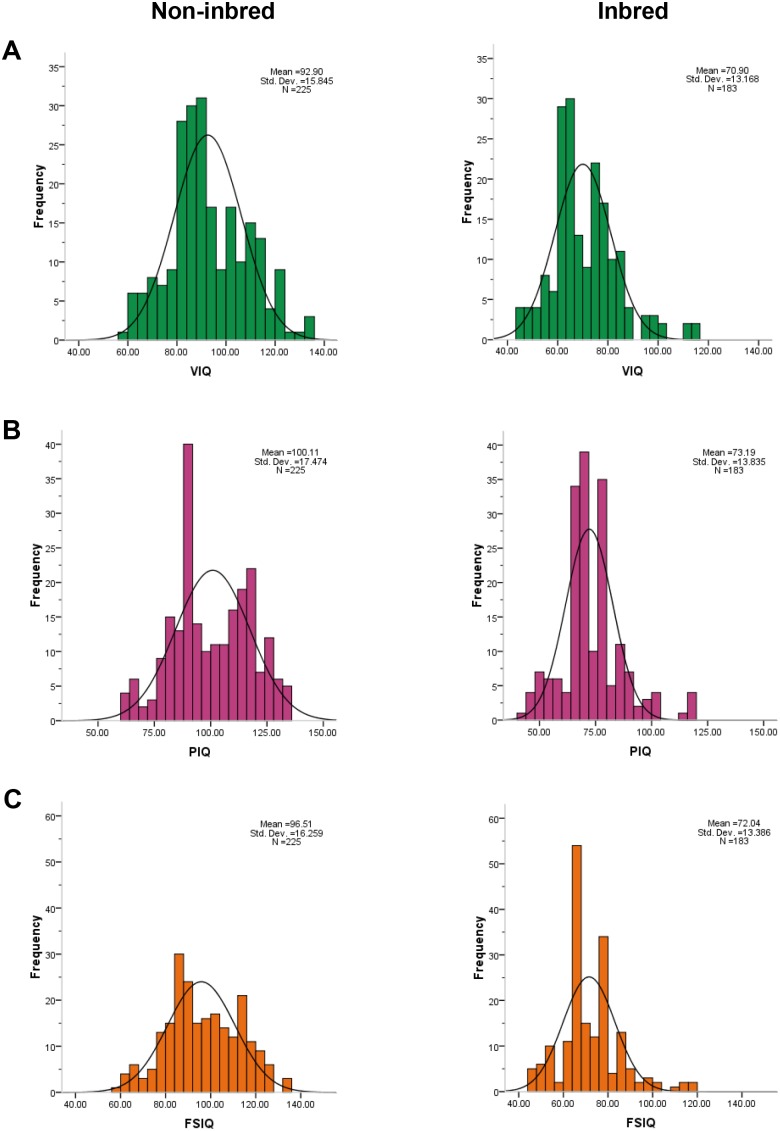
Normal distribution of cognitive abilities among inbred in comparison with non-inbred children.Differences in normal distributions of inbred in comparison with non-inbred children for VIQ, PIQ and FSIQ show highly significant results (at p<0.0001, using One-way Analysis of Variance). The mean difference (95% CI) for VIQ −22.00 (−24.82, −19.17), PIQ −26.92 (−29.96, −23.87) and FSIQ −24.47 (−27.35, −21.59) among inbred groups in comparison with non-inbred found to be statistically significant (at p<0.001, using Tukey-Kramer Comparisons Test). The non-inbred shows a regular pattern, whereas frequency distributions among inbred children represent a shift toward lower values and sparsity toward the high average or superior IQs.